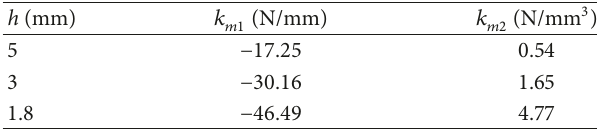
Table 2: Parameters for approximate